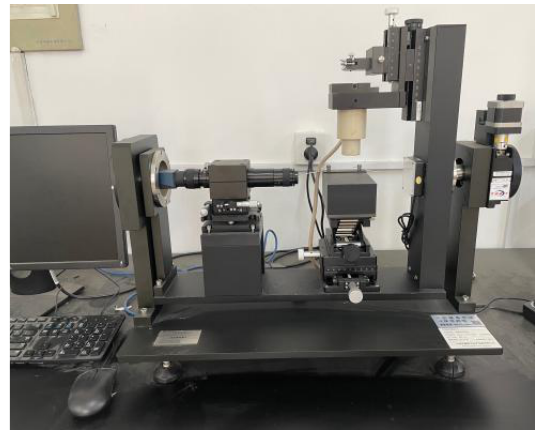
Figure 3. Video optical contact angle measuring instrument.